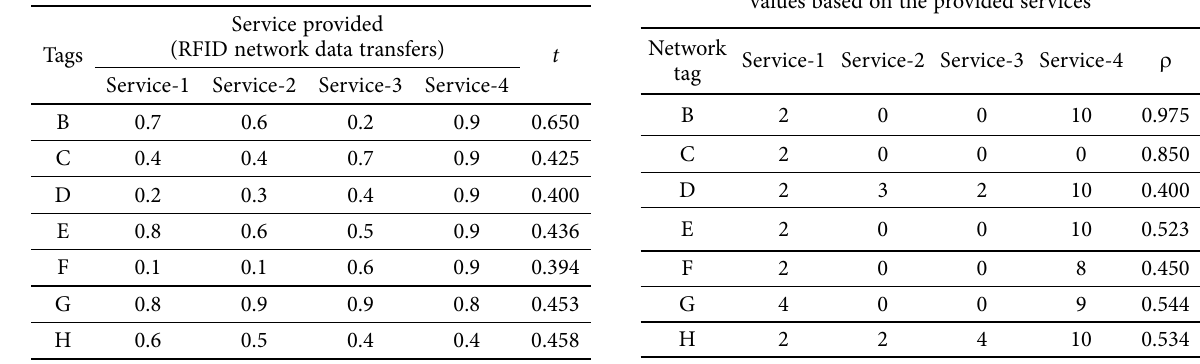
Table. 4 Service-level security assessment of tags Trust